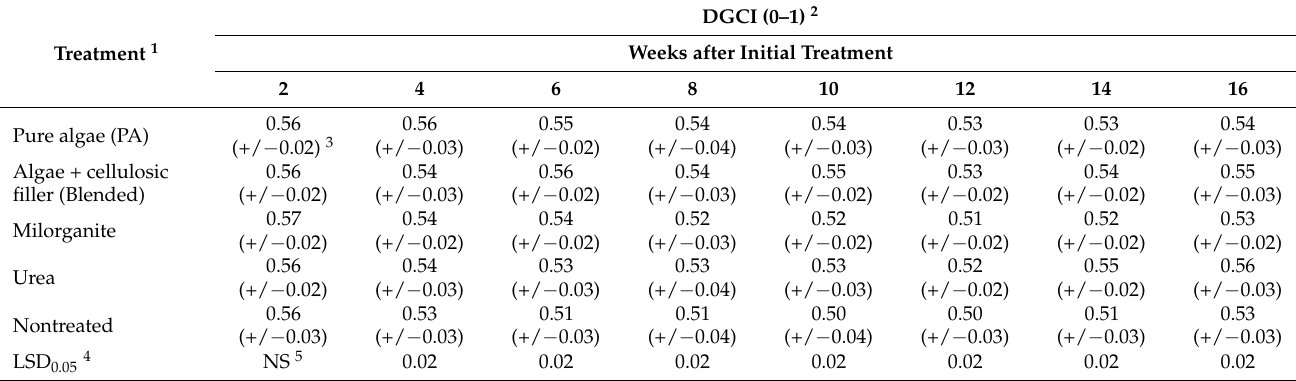
Table 2. Effects of wastewater algae-based fertilizers on Kentucky bluegrass dark green color index (DGCI) growing in a greenhouse in Ames, IA, in 2019–2020 and 2020–2021.